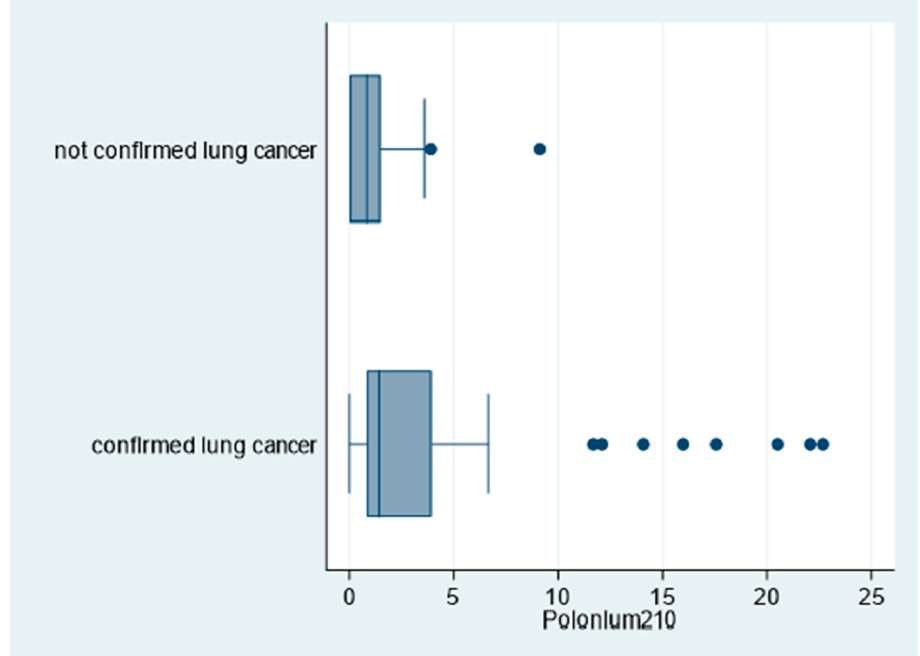
Figure 4. Box plot of polonium-210 (in mBq) by lung cancer status, “Polonium in vivo” study ( n = 60; 10 missing; not confirmed lung cancer n = 13; confirmed lung cancer n = 47). The left and right borders of the box are the lower and upper quartiles; the solid line in the box is the median. The “whiskers”, that is, the lower and upper adjacent values, are used for identifying extreme values in the tails of the distribution. Dots greater than the upper adjacent value, represent outliers.